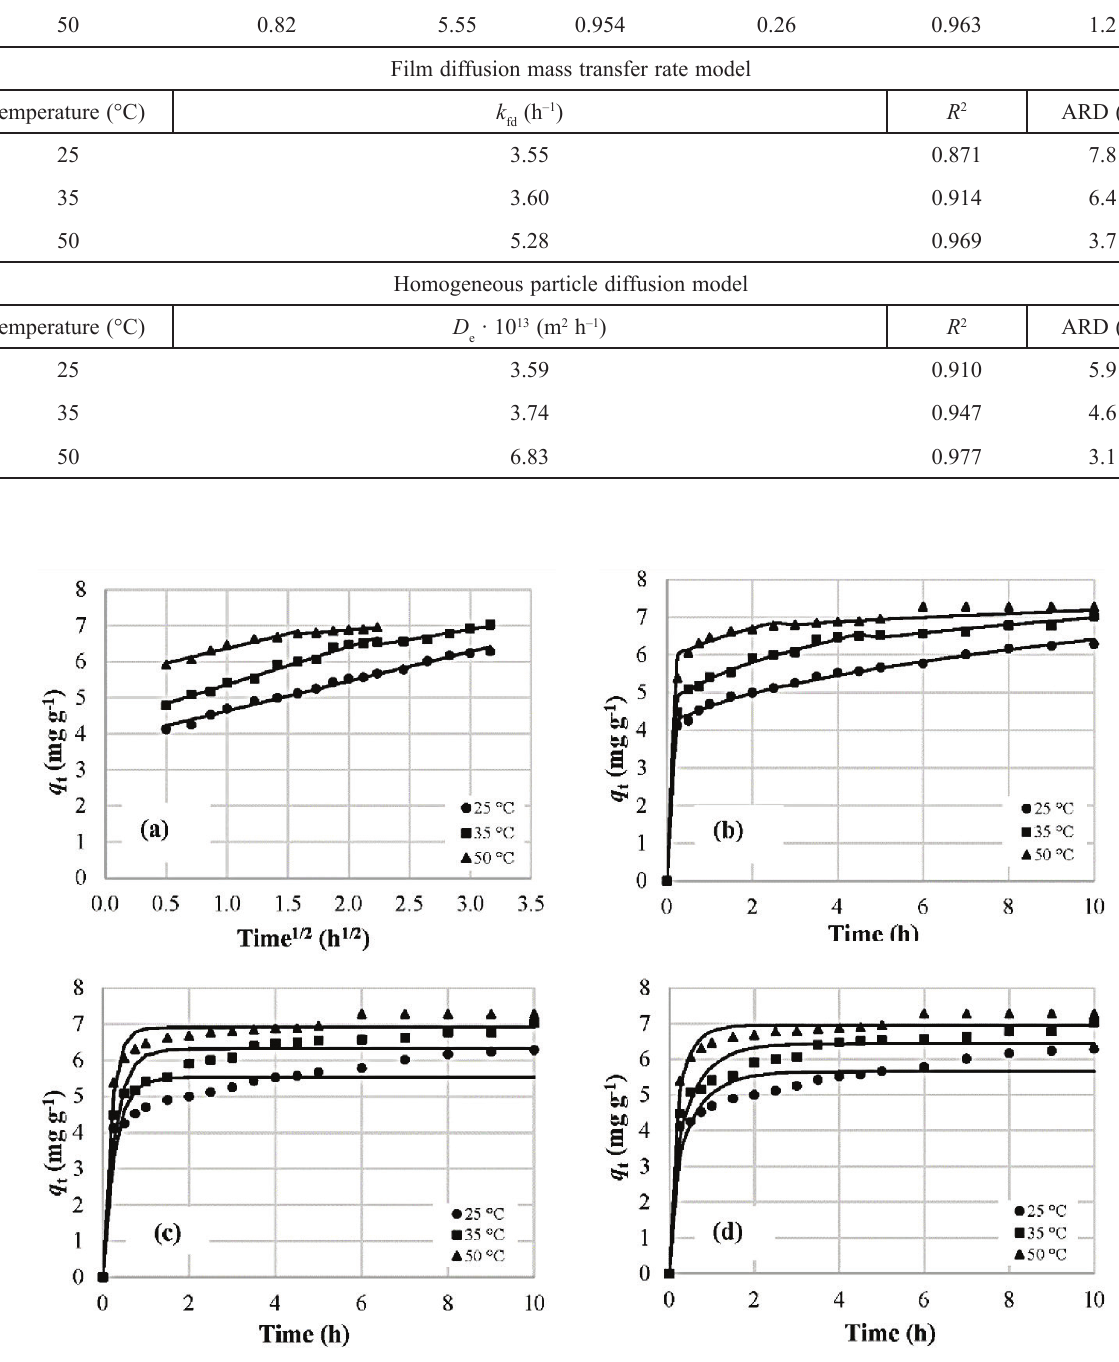
Fig. 7 – Kinetics of cefdinir adsorption on TiO at various adsorption temperatures fitted to (a) Weber-Morris in- 2 traparticle model, predicted using (b) Weber-Morris intraparticle model, (c) Film diffusion mass transfer rate model, (d) Homogeneous particle diffusion model (C = 10 mg L –1 , Adsorbent loadings = 1.5 g L –1 , pH = 0